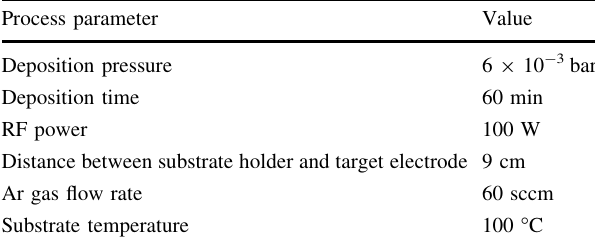
Table 1 Process parameters employed during the deposition of